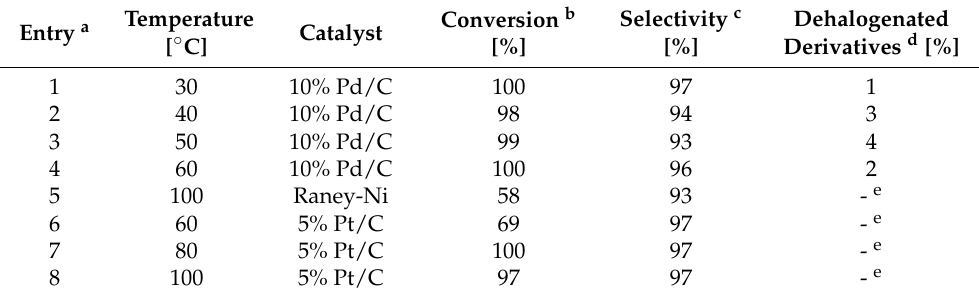
Table 5. Reductive amination with different catalysts at various temperatures.